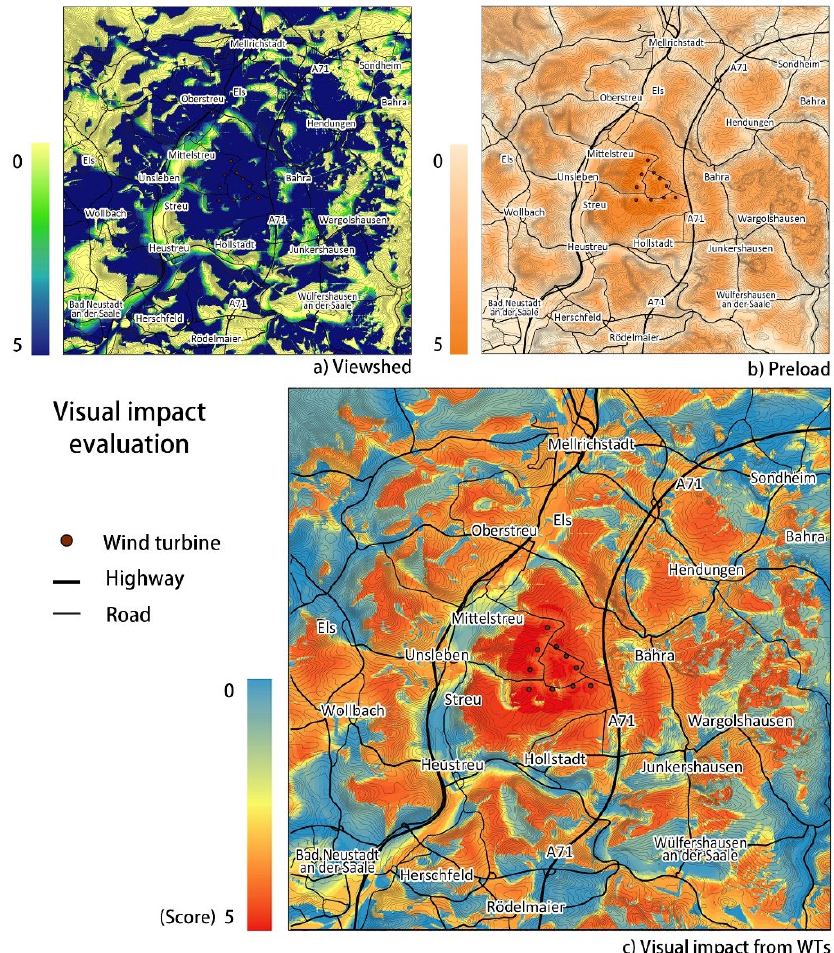
Figure 5. ( a – c ). Results of visual impact from wind turbine evaluation.